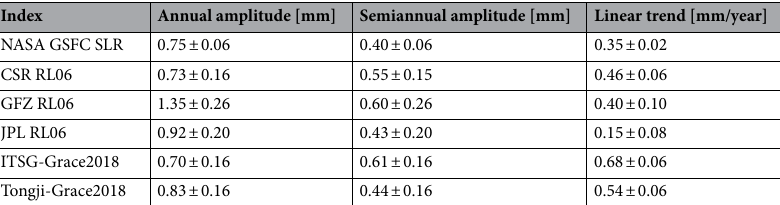
Table 6. Amplitudes and phases of annual and semiannual components and linear trends of GMOM change from GRACE and GSFC SLR ΔC 20 from January 2005 to December